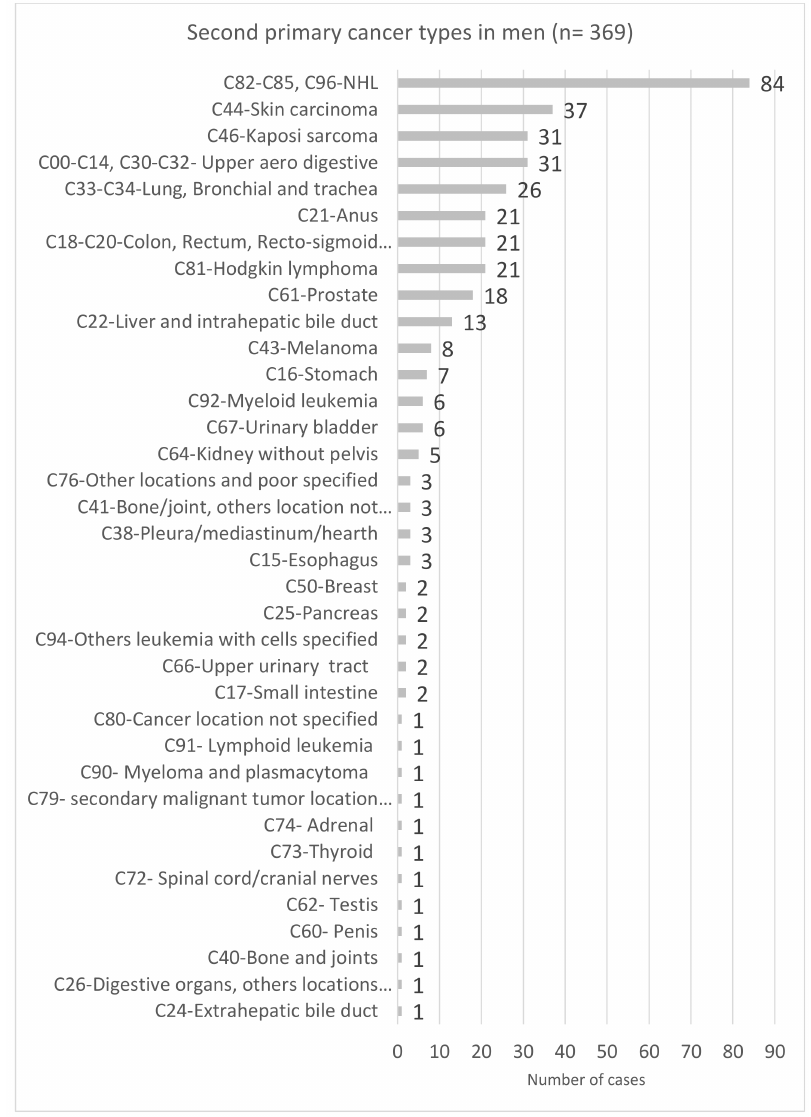
Figure 2. Spectrum of second primary cancer types in men living with HIV in the French Dat’AIDS cohort ( n =